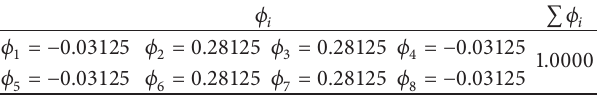
Table 2: Shape functions obtain by matrix triangular